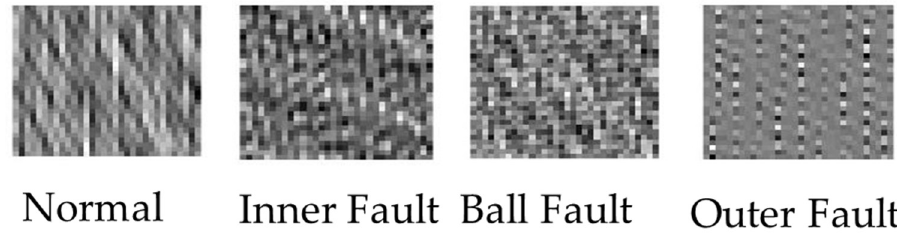
Figure 4. Signal-to-gray image construction.